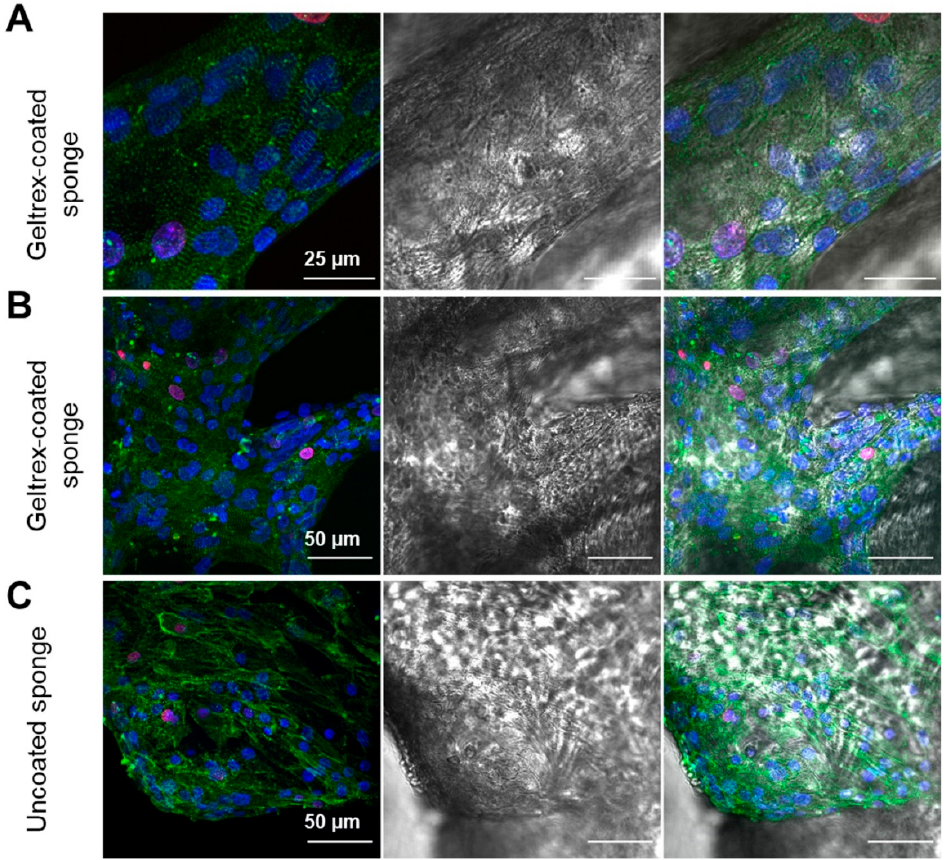
Figure 9. Staining of α -actinin, Ki-67, and cell nuclei to document cell alignment and proliferation of iPSC-CMs on I. labyrinthus scaffolds. Left panel shows fluorescence channels of α -actinin (green), Ki-67 (magenta), and nuclei (blue), middle panel represents brightfield image, and right panel overlay of brightfield and fluorescence channels. ( A ) iPSC-CMs on Geltrex®-coated scaffold representing sarcomere structures of cells attached to a chitin fiber and the presence of a minor population of Ki-67 positive cells. ( B , C ) Representative images of iPSC-CMs on Geltrex®-coated and uncoated sponge scaffolds.